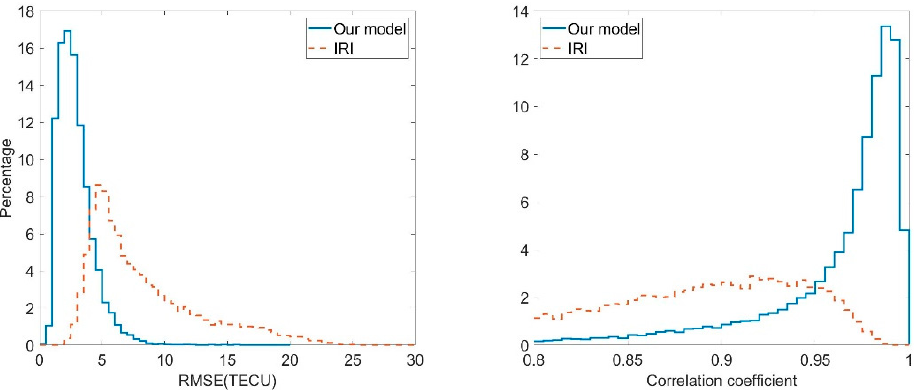
Figure 4. The distribution of RMSEs ( left ) and CCs ( right ) between the output maps and the target maps (solid line), as well as between IRI TEC maps (+2 h) and the target maps (dotted line) for the test set.